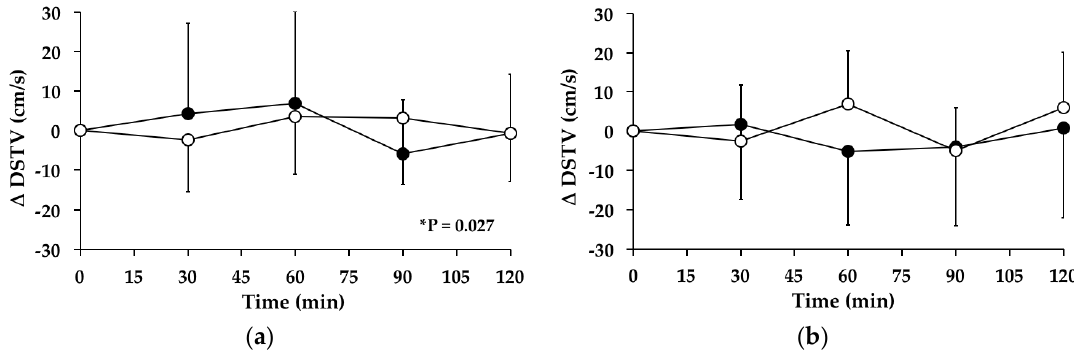
Figure 5. Mean change ( (cid:52) ) in double-support time variability (DSTV) on “WW” ( ) and “GW” ( ) days in subjects: ( a ) with postprandial hypotension (PPH); and ( b ) without PPH. Data are mean ± standard deviation (SD) represented by vertical bars. * p = 0.027 for the change in DSTV over time on the “GW” day.